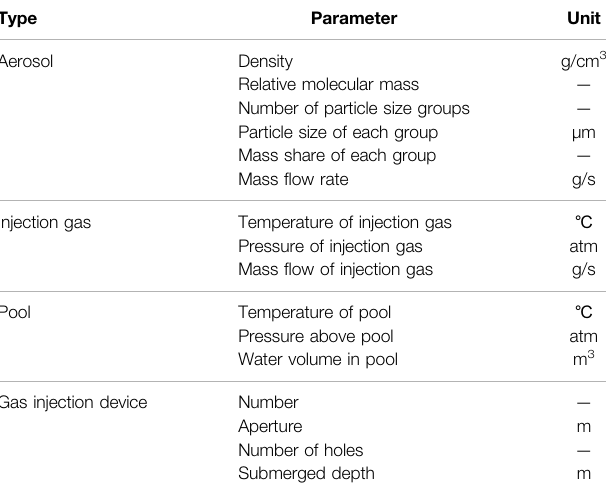
TABLE 1 | Main input